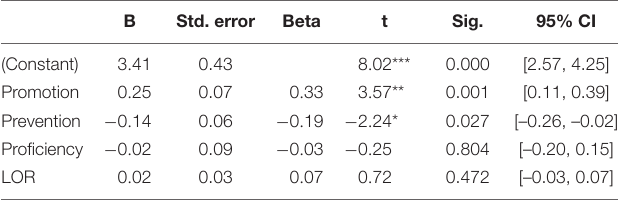
TABLE 6 | Multiple regression results for regulatory focus with DCT IPD + score as the outcome variable.